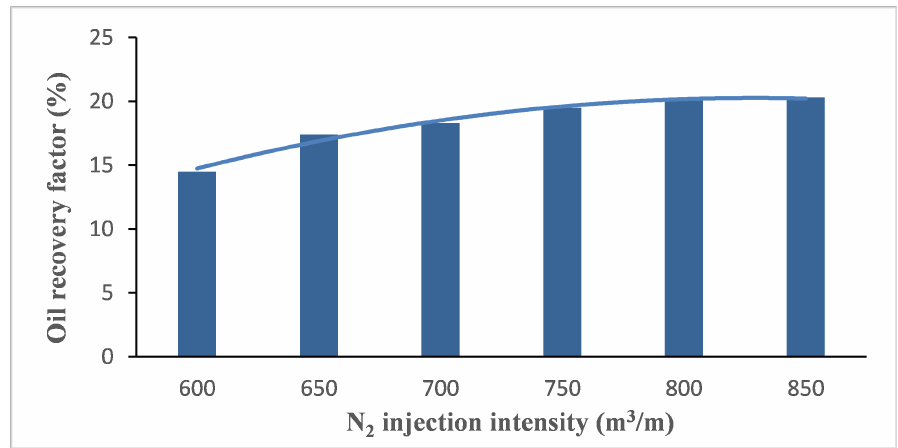
Figure 16. The comparison of huff-n-puff under different N 2 intensities.